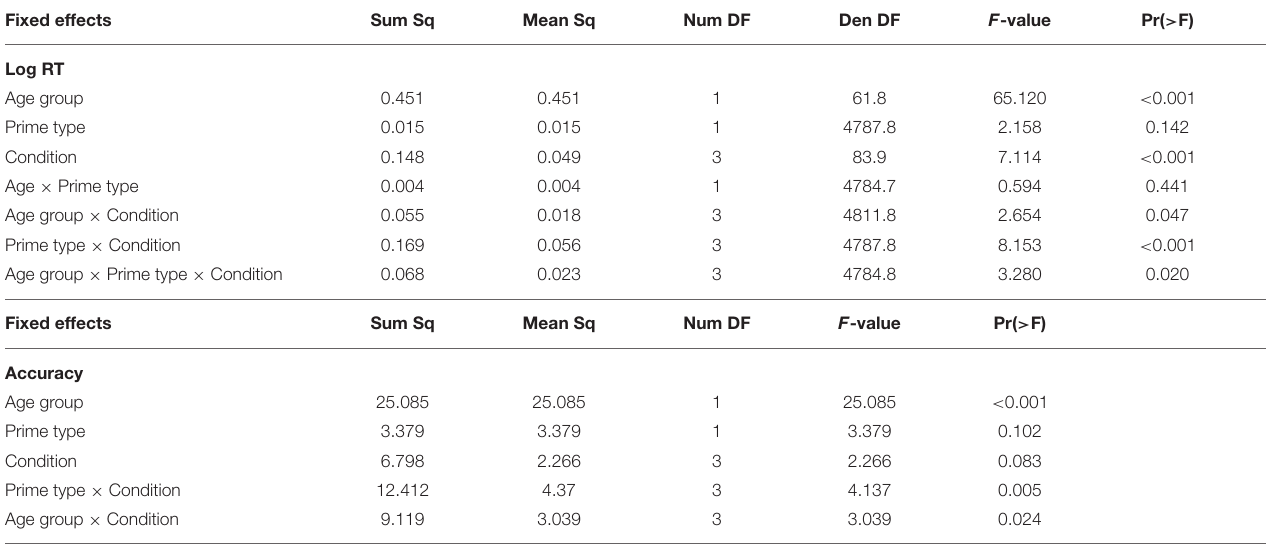
TABLE 7 | Results from the ANOVA approach to linear mixed-effects model analysis of log RT and accuracy rates in Experiment 3 with 57ms prime